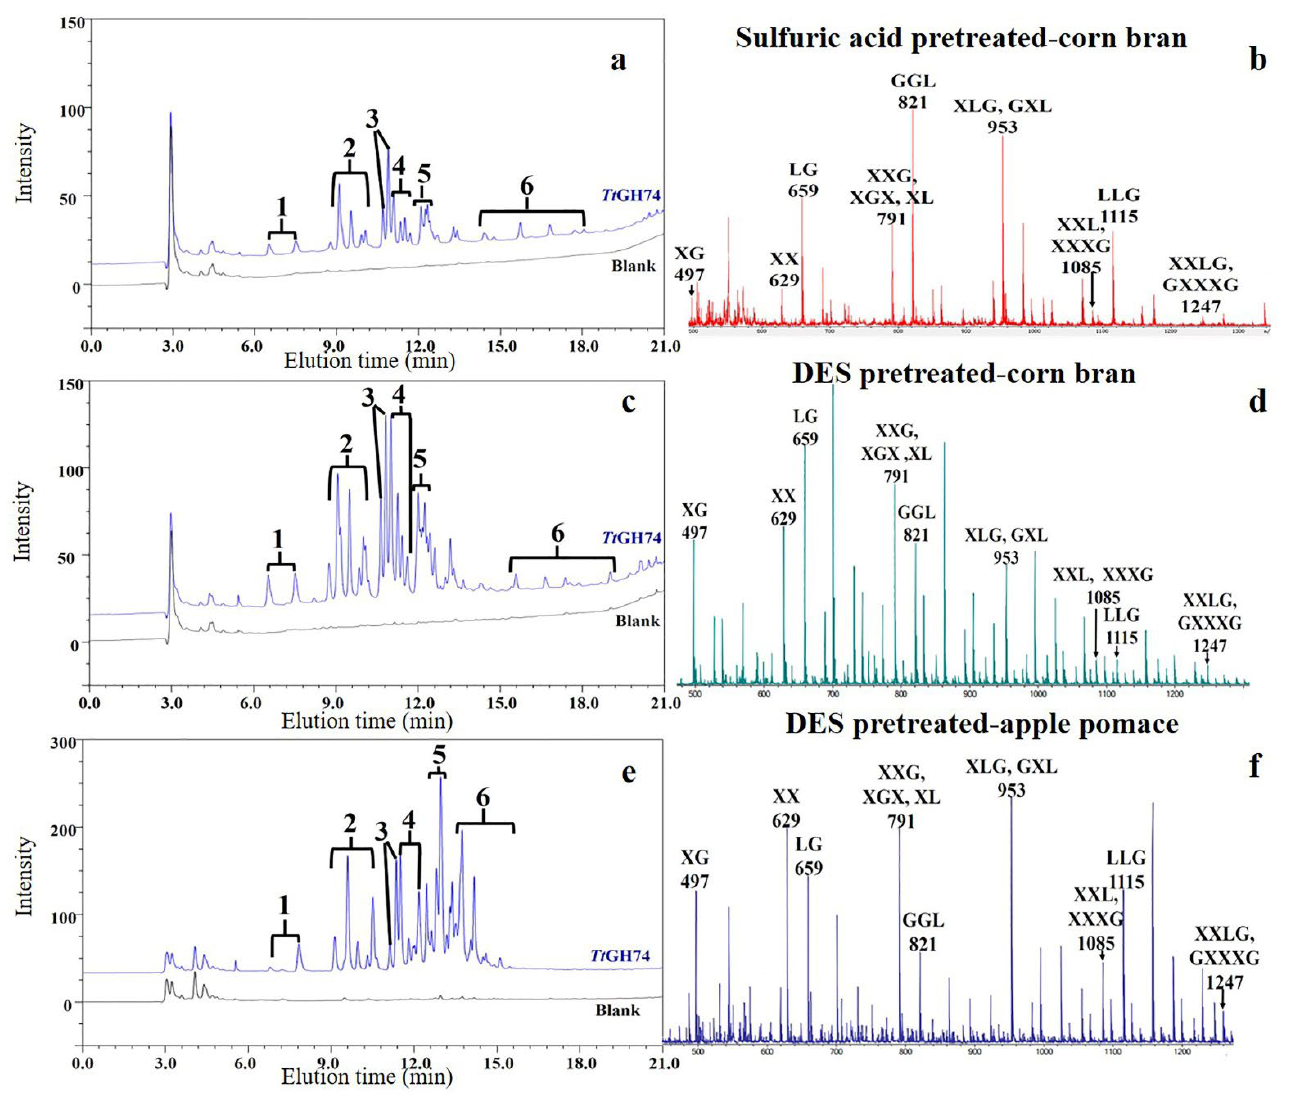
Figure 7. HPAEC-PAD ( left ) and MALDI-TOF MS ( right ) analysis of end-products generated by Tt GH74 from sulfuric-acid-pretreated corn bran ( a , b ), DES-pretreated corn bran ( c , d ) and apple pomace ( e , f ). The blank in the HPAEC-PAD represents a control experiment without Tt GH74.